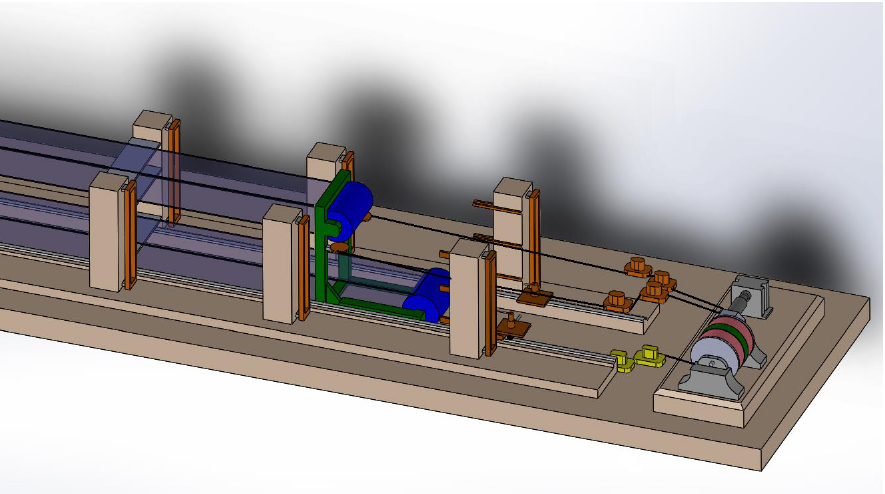
Figure 1. Continuous pickling line looper. The annual capacity is 1,200,000 tons; the looper capacity is 1150 m; the maximum strip width is 1600 mm; and the maximum thickness is 5 mm. Materials 2021 , 14 , x FOR PEER REVIEW